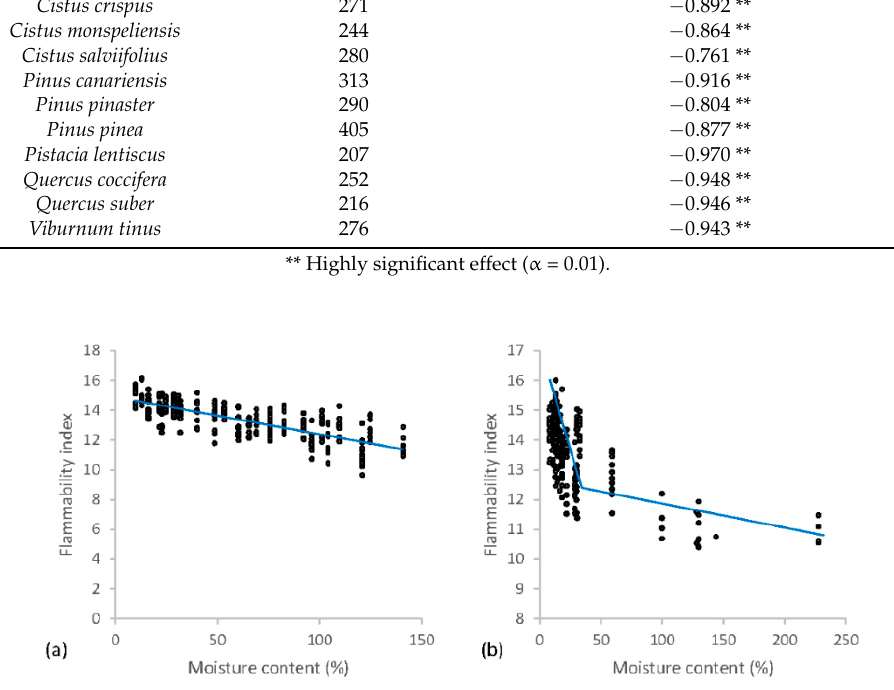
Figure 3. Flammability indices (FI) as a function of fuel moisture content (MC in %) for ( a ) Pinus pinaster (1st group) and ( b ) Cistus albidus (2nd group) with appropriate trend curves.